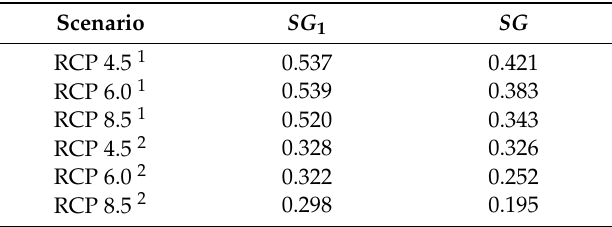
Table 9. Sustainability by SG 1 and SG 2 for different climate change